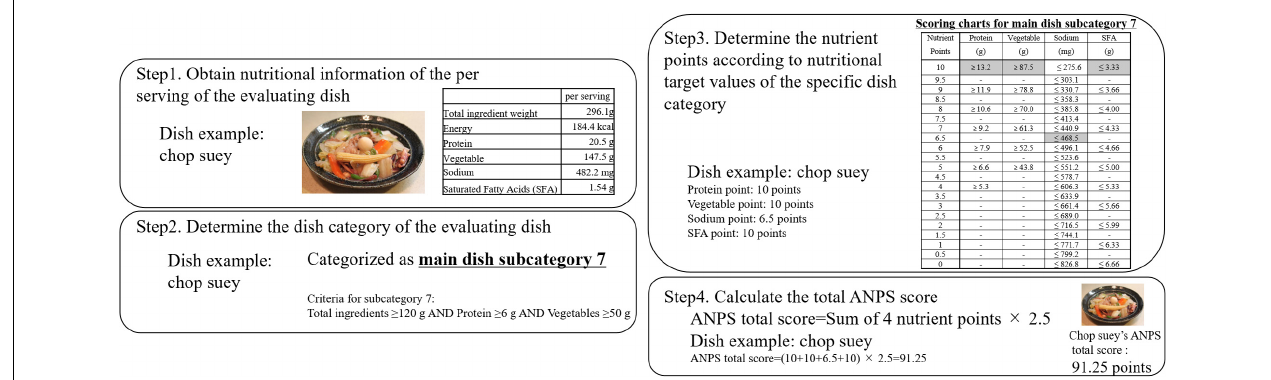
FIGURE 2 | Schematic steps for the scoring algorithms of the Ajinomoto Group Nutrient Profiling System (ANPS). The scoring method and algorithm of the ANPS is determined by using the four steps indicated. The graph shows an example of the chop suey (happosai) recipe. Step 1 consists in determining the nutritional value of the dish. The recipe was obtained from the Japanese Ministry of Agriculture, Forestry and Fisheries website (https://www.maff.go.jp/j/seisan/kakou/mezamasi/recipe/recipe246.html) and the nutrient calculation was performed using Excel Eiyo-kun ver. 8; Kenpakusha, Tokyo, Japan. In step 2, the dish category is determined by using the criteria described in Table 1 . In the case of chop suey, it is classified as main dish subcategory 7. In step 3, the four nutrient points are confirmed according to the target value determined from the dish category described in Table 3 . In the case of chop suey, the protein value is 20.5 g per serving scoring 10 points. A serving of vegetables (147.5 g) scored 10 points, a serving of sodium (482.2 mg) scored 6.5 points, and a serving of saturated fatty acids (1.54 g) scored 10 points. Step 4 consisted in calculating the ANPS total score by adding the total nutrient points and multiplying them by 2.5. In the case of chop suey, the nutrient points add up to total of 36.5 points and the total ANPS score for chop suey is 91.25 points.